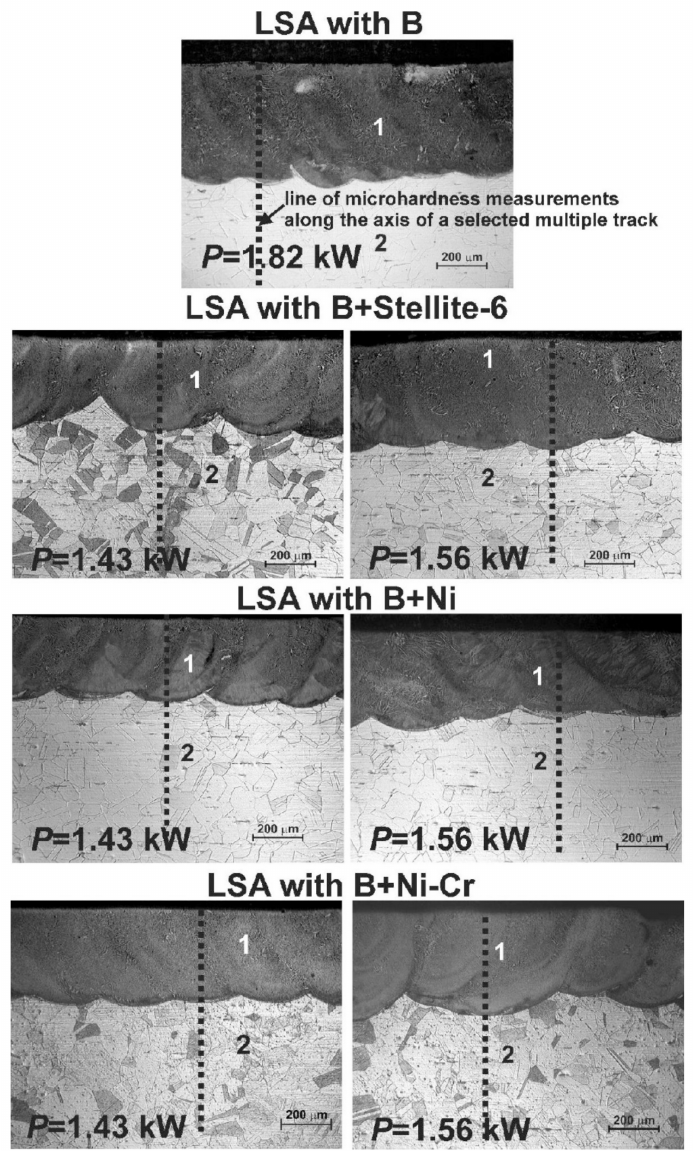
Figure 2. The lines of microhardness measurements along the axis of a selected multiple track based on the microstructure of laser-alloyed layers shown in the paper [63]: 1—re-melted zone (MZ); 2—substrate material (316L steel) without the changes in the microstructure of the heat-affected zone